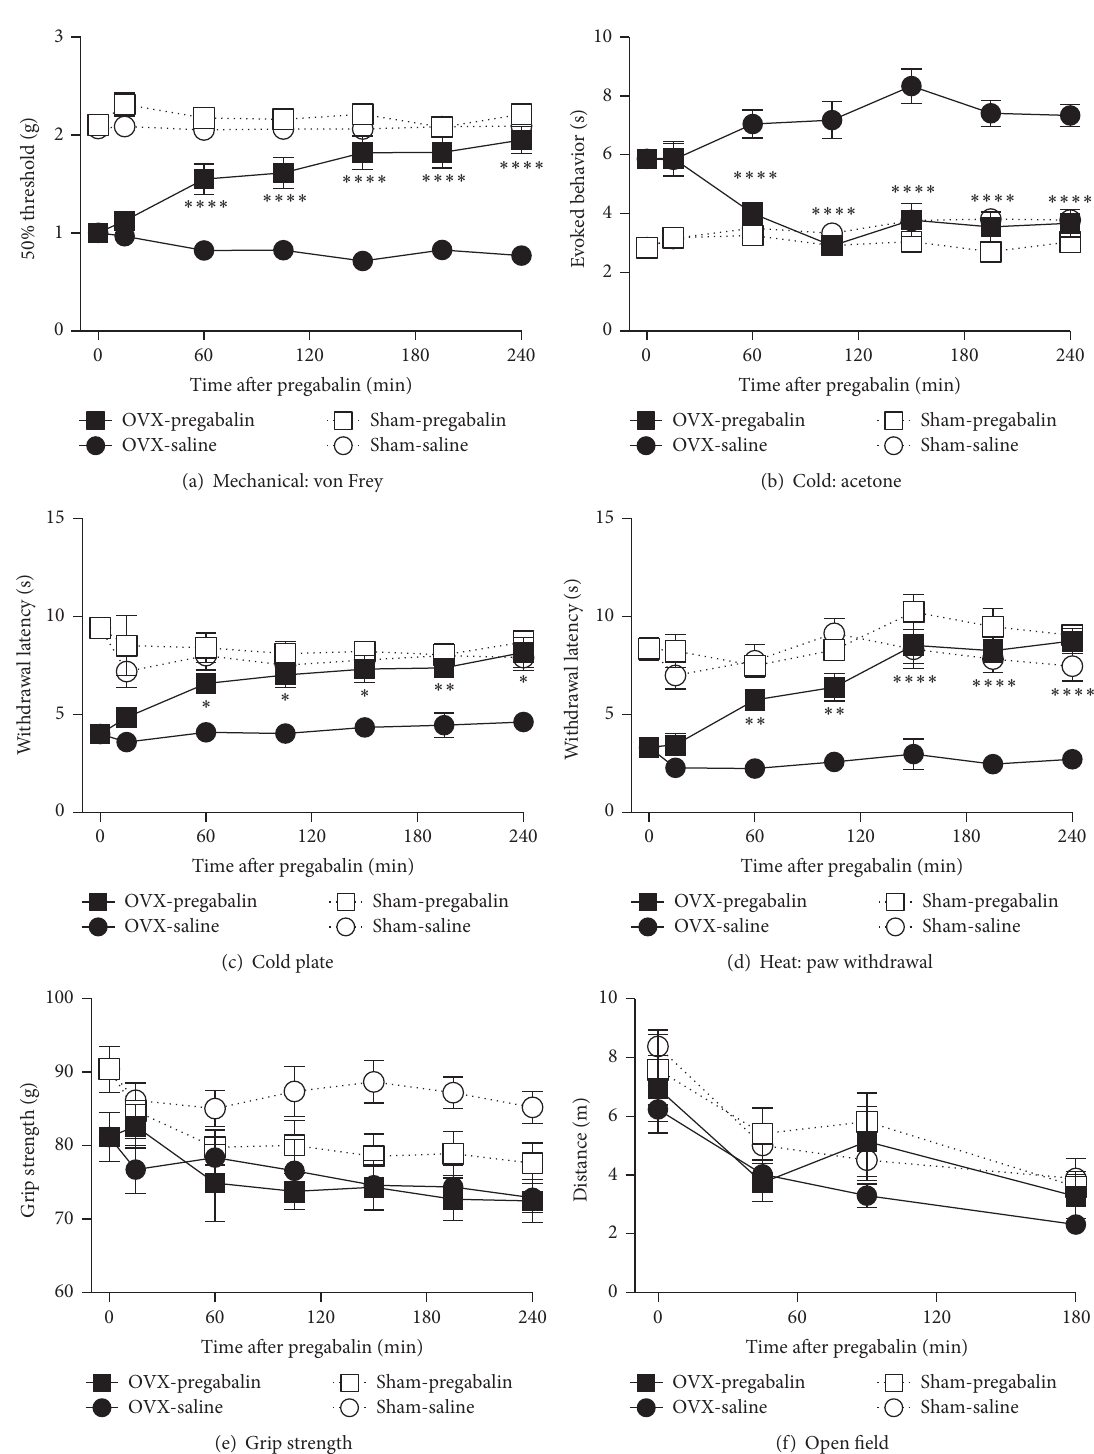
Figure 6: Efficacy of acute pregabalin treatment on chronic osteoporosis-related cutaneous and musculoskeletal pain and physical function. The effects of acute intraperitoneal pregabalin (100mg/kg) injections were measured for several hours in mice, 6 months following ovariectomies or sham surgeries. Pregabalin significantly reverses cutaneous plantar hypersensitivity to mechanical stimuli (von Frey assay) (a) and cold (acetone test) (b) and cold plate (c) tests and to heat (radiant heat paw withdrawal assay) (d) in OVX, but not sham-operated, mice. Pregabalin had no effect on OVX-operated mice compared to saline but did result in a trend towards decreased grip strength in sham- operated mice (e). No effects were observed in the open field assay (f). Data are expressed as means ± standard error of the mean. OVX: ovariectomized; ∗ 𝑃 < 0.05 ; ∗∗ 𝑃 < 0.01 ; ∗∗∗∗ 𝑃 < 0.0001 ; and OVX group with pregabalin versus vehicle, two-way repeated measures analysis of variance (factors = group × time), followed by Tukey’s test for multiple